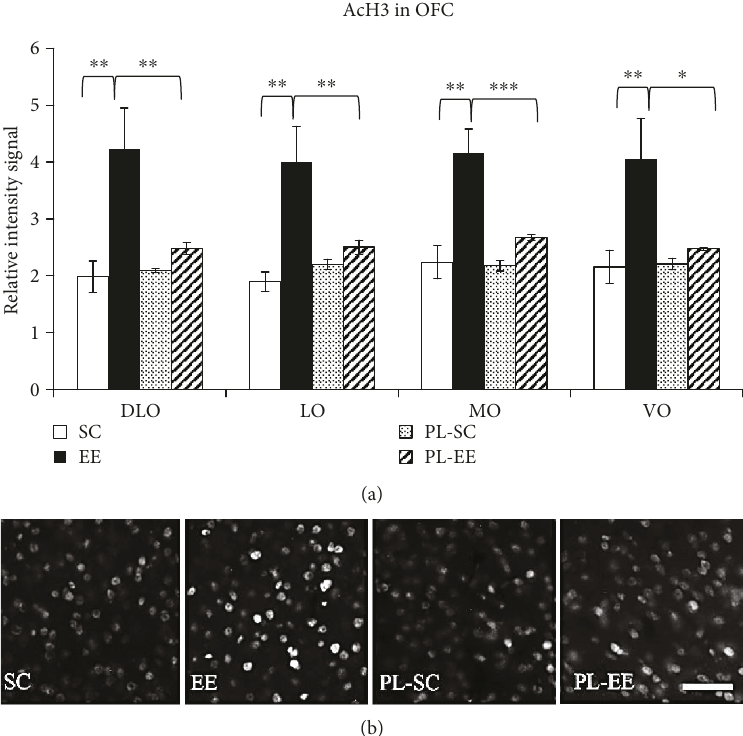
Figure 4: (a) H3 acetylation on L14 in subregions of OFC for SC (open columns), EE ( fi lled columns), PL-SC (dotted columns), and PL-EE (hatched columns) mice 1 hour after the learning phase. PL-SC did not di ff er from PL-EE mice. Only EE animals showed signi fi cant di ff erences with respect to their controls in OFC areas; (one-way ANOVA ( p < 0 01 ), post hoc analysis Holm-Sidak method, SC versus PL-SC and PL-SC versus PL-EE ( p > 0 05 ) for all subregions). MO: EE versus SC ( p < 0 001 ), EE versus PL-EE ( p = 0 001 ). LO: EE versus SC ( p < 0 001 ), EE versus PL-EE ( p = 0 007 ). VO: EE versus SC ( p = 0 004 ), EE versus PL-EE ( p = 0 013 ). DLO: EE versus SC ( p = 0 001 ), EE versus PL-EE ( p = 0 008 ). ∗ p < 0 05 ; ∗∗ p < 0 01 ; ∗∗∗ p < 0 001 ; error bars =SEM. (b) Representative panel of histone H3 acetylation in DLO for SC, EE, PL-SC, and PL-EE mice 1h after learning; scale bar: 50 μ